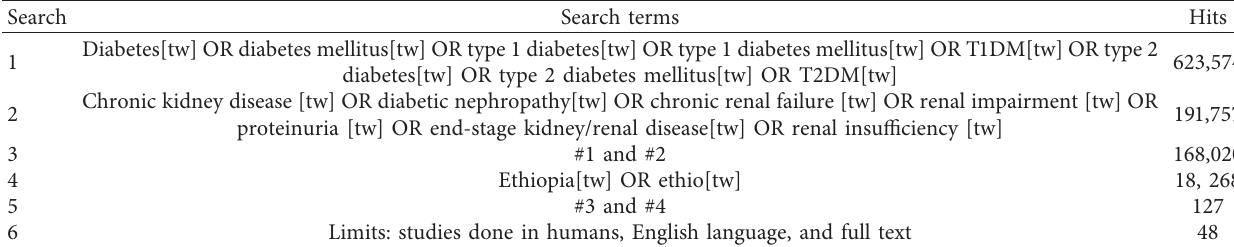
Table 1: PubMed search